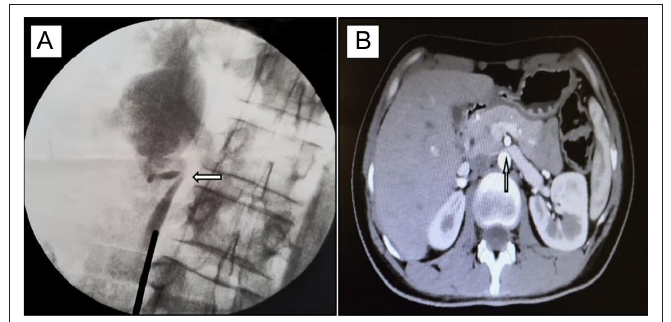
Figure 1. Retrograde pyelogram (RPG) and computed tomography (CT) angiography samples of the patient. A: The curvature and stenosis of the right ureter on RGP is shown with arrow. B. Compression of the left kidney vein between the abdominal aorta and the superior mesenteric artery on CT angiography is marked with an